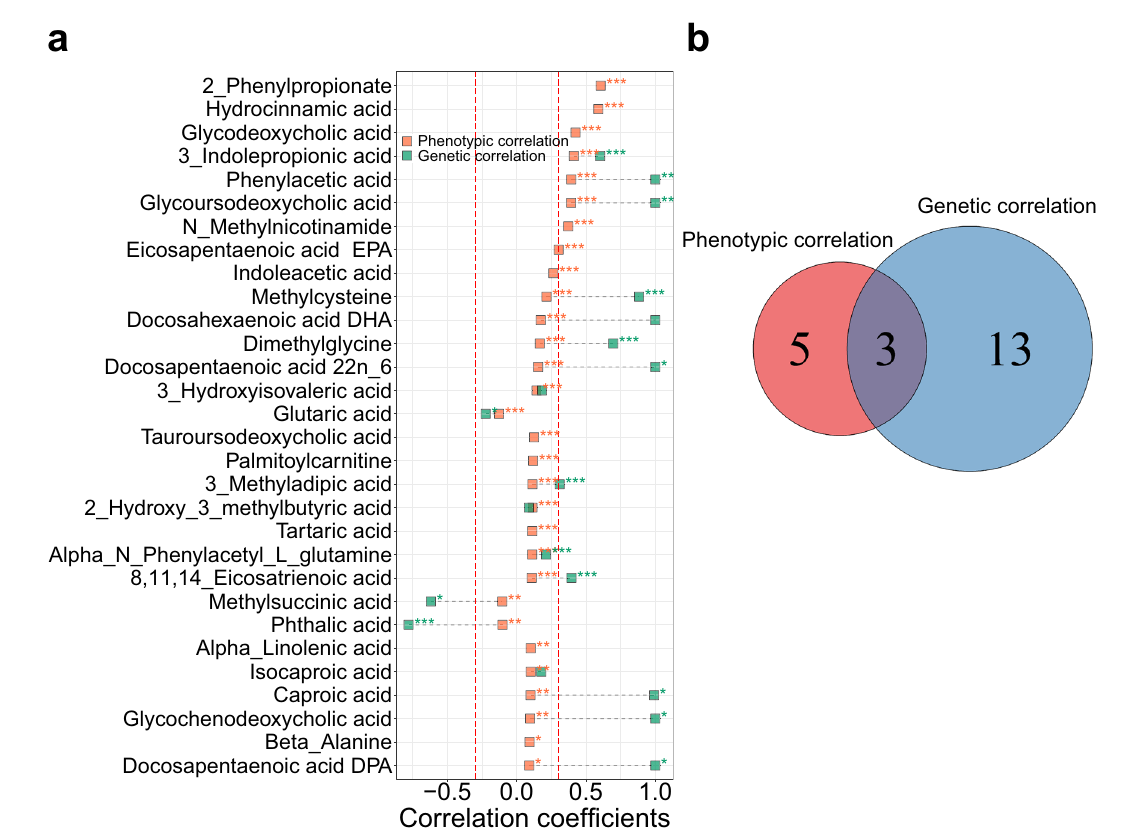
Fig. 2 | Phenotypic and genetic correlations between paired fecal and blood metabolites. a Phenotypic and genetic correlations between paired fecal and blood metabolites for the top 30 metabolites that are ranked by phenotypic cor- relations. Phenotypic correlations between paired fecal and blood metabolites are estimated by partial Spearman correlation analysis, adjusted by age, sex and BMI. Genetic correlations are calculated using bivariate GREML analysis. Correlations with FDR<0.05 and ∣ r ∣ >0.3 (red dashed lines) are considered signi fi cant. FDR is